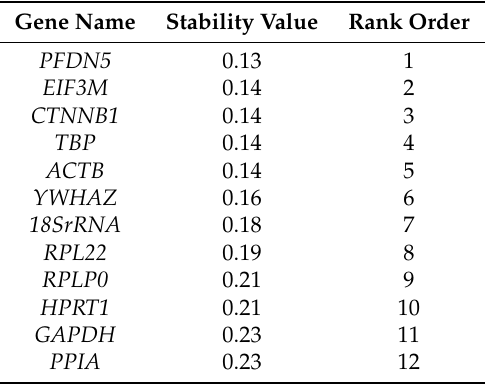
Table 2. Expression stability of reference genes by NormFinder analysis.